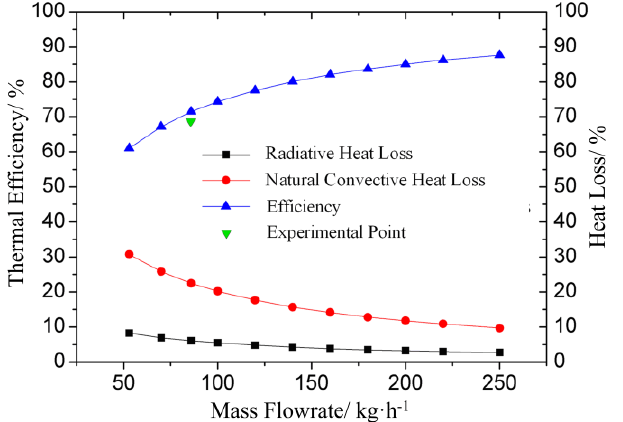
Figure 12. Curve of thermal efficiency with mass flow rate.